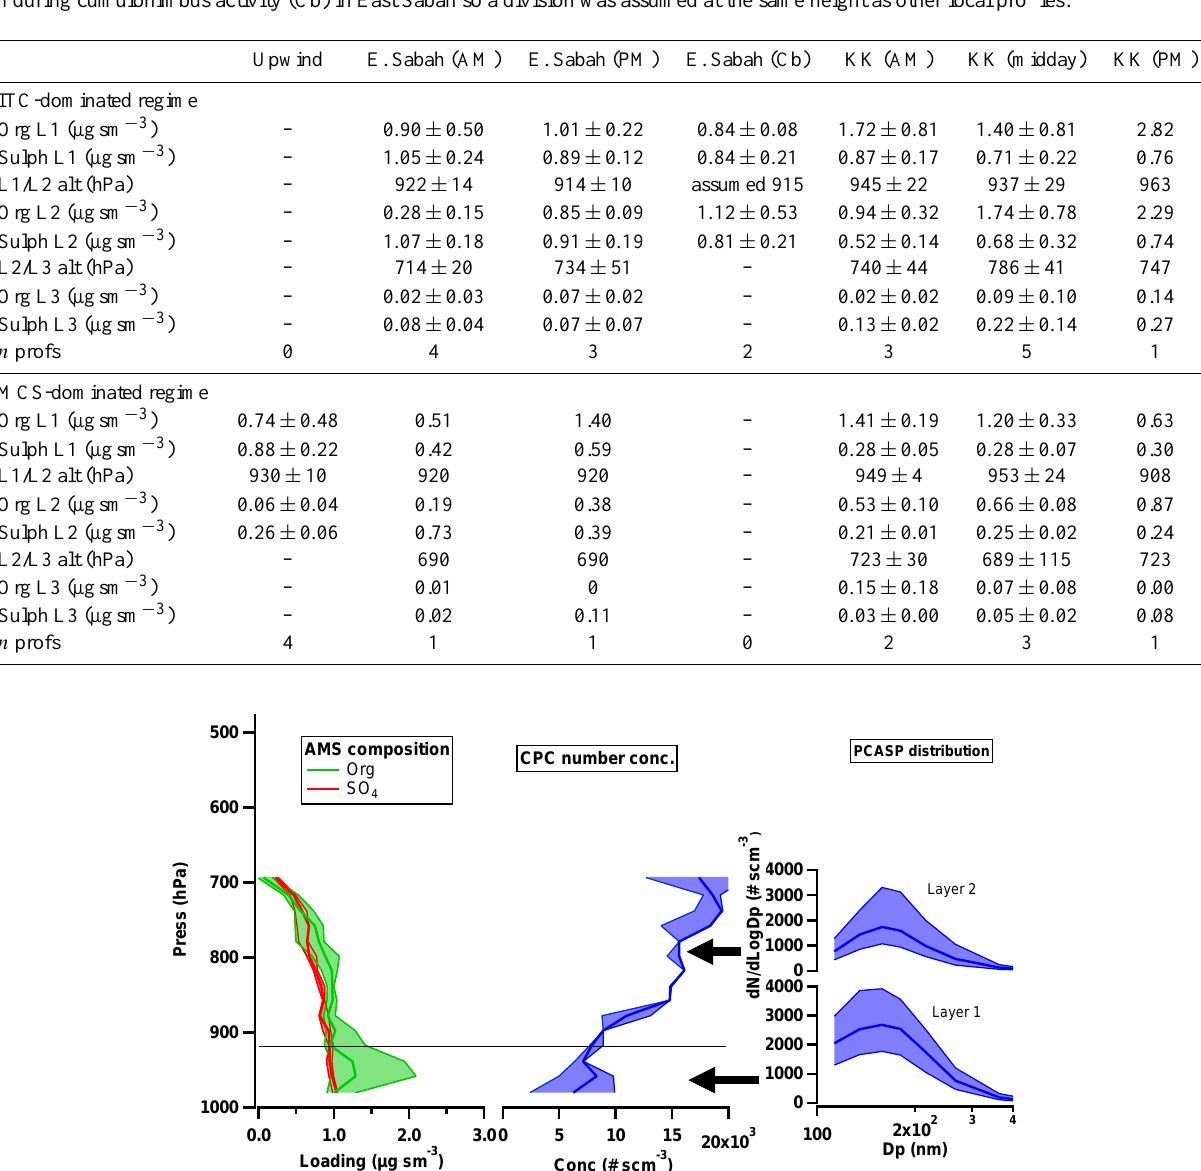
Table 2. Summary of average estimated heights of layer boundaries, and average aerosol loadings in different layers. Uncertainties on figures represent standard deviation of averages from each individual profile and represent variability between profiles. No clear divide in layers was seen during cumulonimbus activity (Cb) in East Sabah so a division was assumed at the same height as other local profiles.